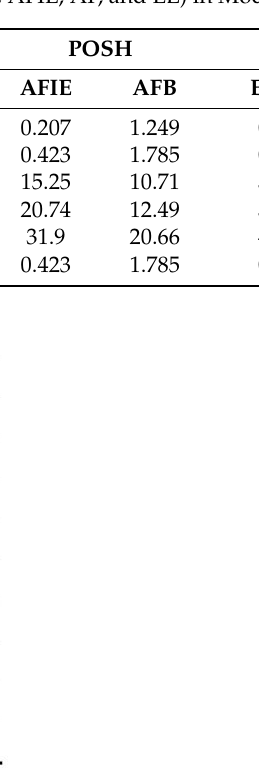
Table 7. The results of SITR and POSH approaches in term of (FCT, AFIE, AF, and EL) in Mode 2.